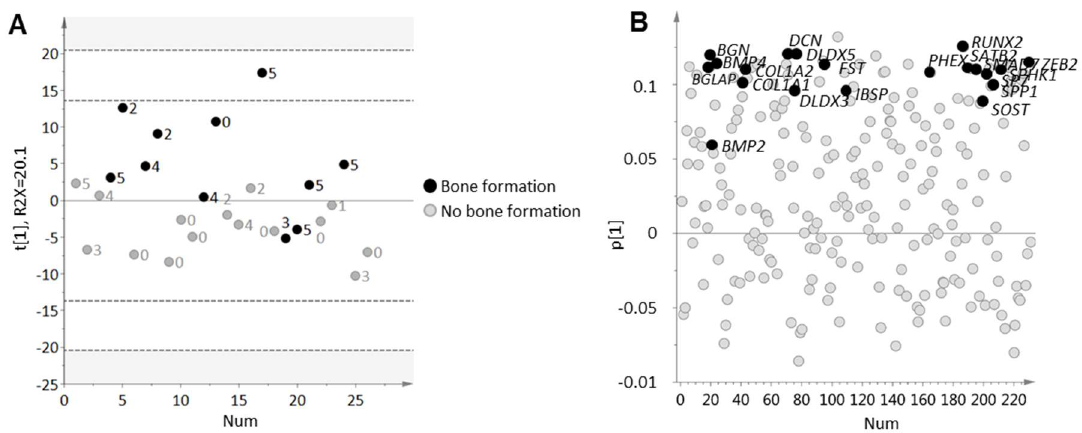
Figure 5. Orthogonal projections to latent structures discriminant analysis of MetaCore suggested upstream regulators of bone cells analyzed in relation to bone formation in metastasis samples. Class membership was set as ongoing or no ongoing bone formation, based on histological examination of tissue section. ( A ) score plot of 26 bone metastases samples where each dot corresponds to one metastasis sample collected from prostate cancer patients. The label (0–5) describes gradually increasing osteocyte rich tissue areas; ( B ) loading plot of 231 gene products suggested to regulate bone cell activity in metastasis samples. Genes with positive loading ( p ) are highly expressed in patient class with ongoing bone formation and vice versa. Gene products involved in bone morphogenetic protein and/or transforming growth factor β signaling are indicated.